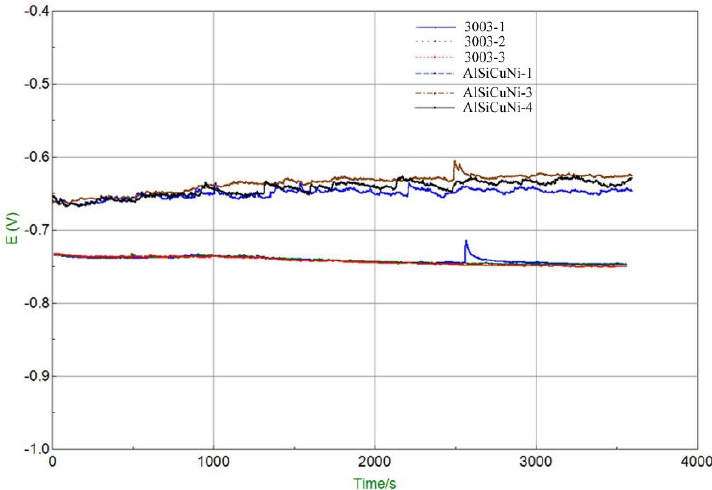
Figure 11. Open circuit potential fitting curve of filler metal and base metal. Table 5. Open circuit potential of filler metal and base metal at different time. Specimen No.